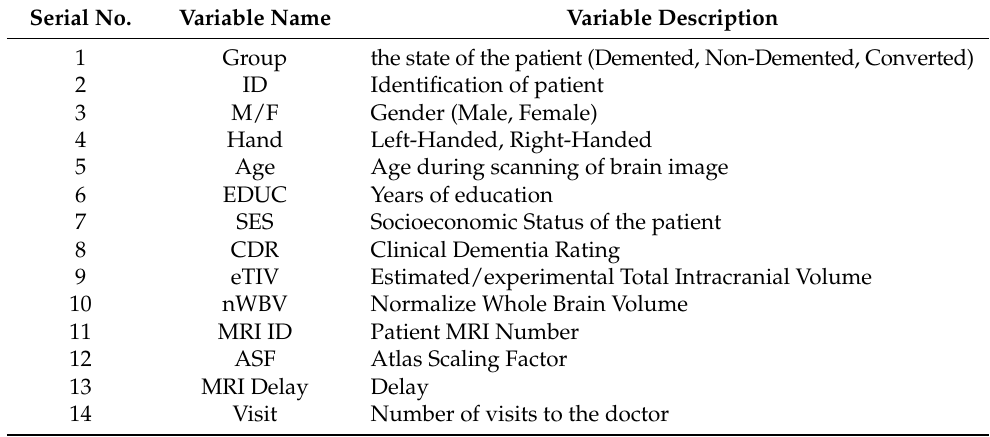
Table 2. Measures Included in the Data